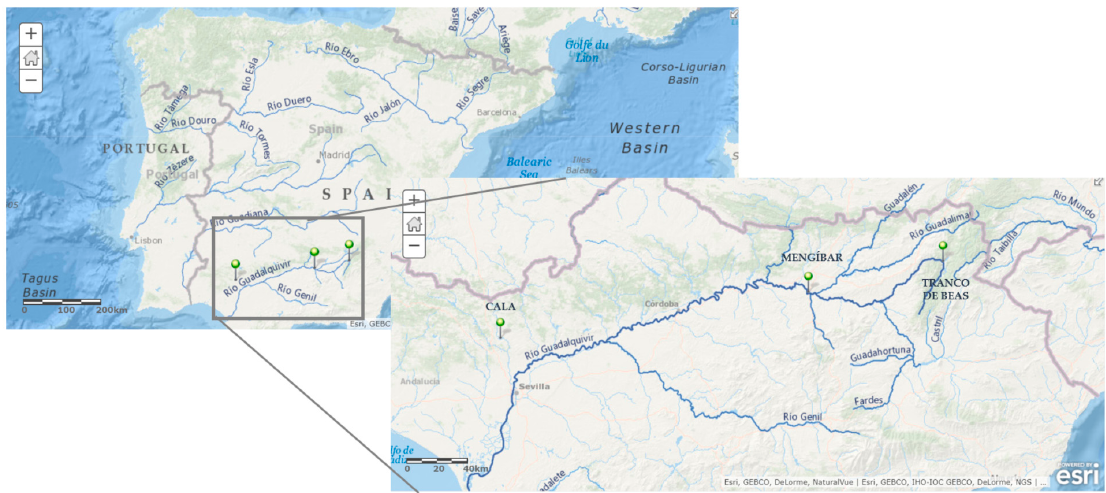
Figure 1. Location of the three plants along the Guadalquivir Basin.